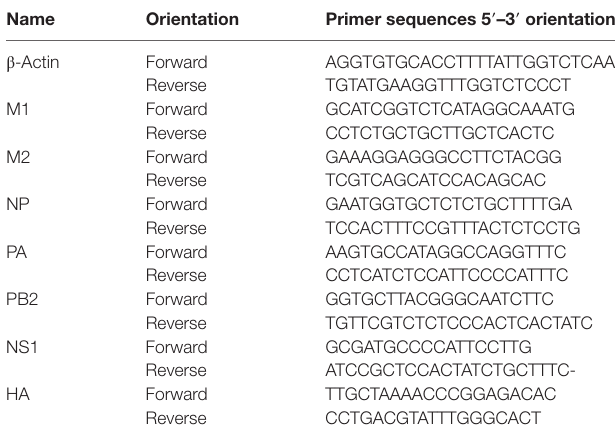
TaBle 1 | Primer sequences for quantitative real-time polymerase chain